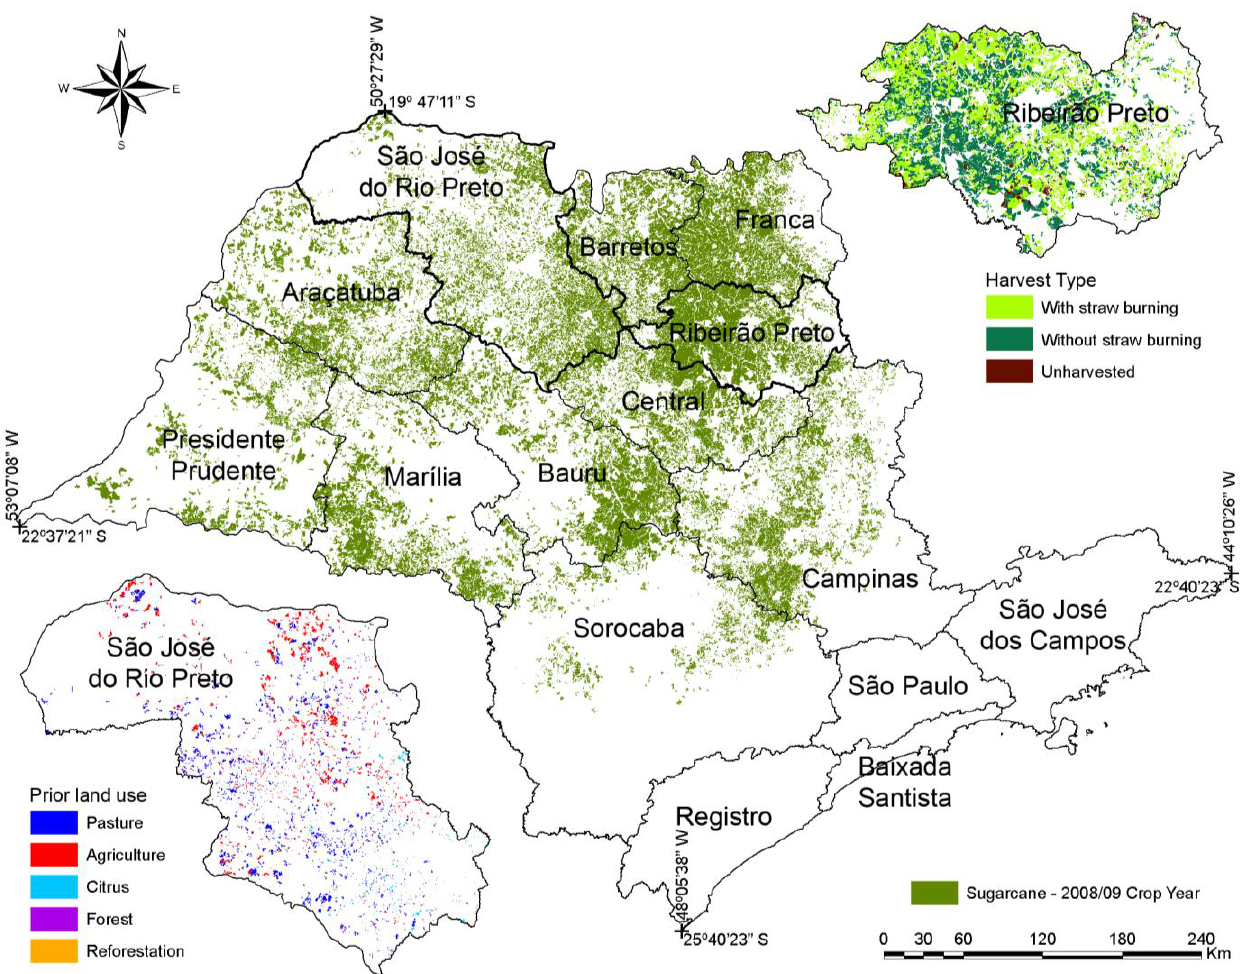
Figure 6. Cultivated sugarcane areas by Administrative Regions (ADRs) of São Paulo state for the 2008/09 crop year. The ADR of Ribeirão Preto is detached to exemplify the map of harvest type during the 2008/09 crop year. The ADR of São José do Rio Preto is detached to exemplify the map of prior land use in the expanded sugarcane fields of 2008/09 crop